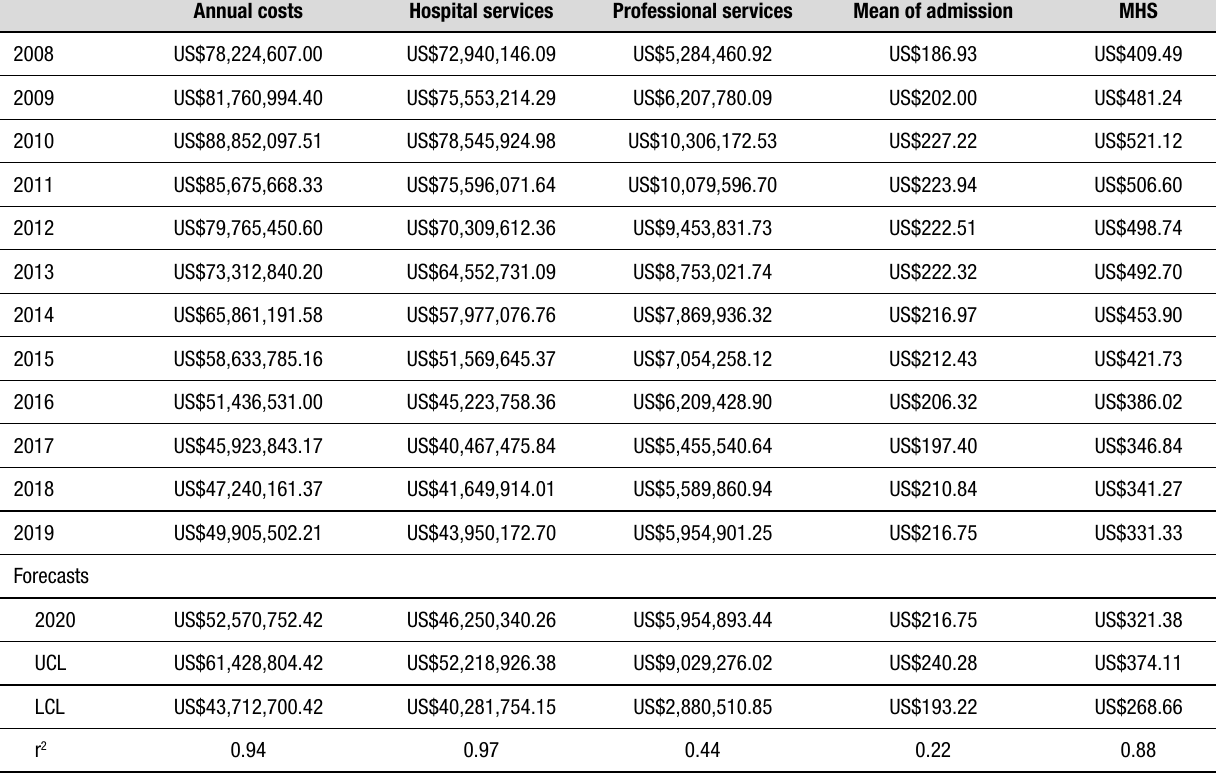
Table 2. Total costs due to schizophrenia and common mental disorder by